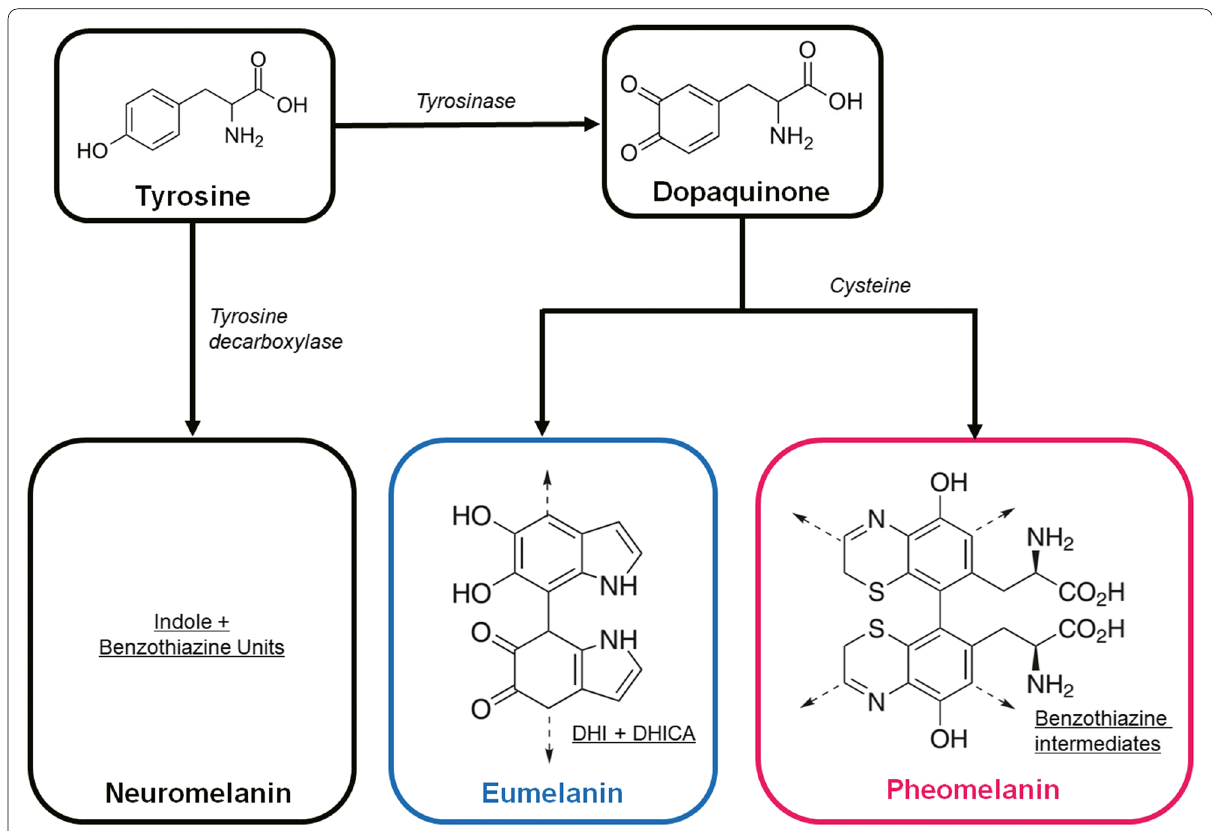
Fig. 2 Biosynthetic pathways of three different types of natural melanin in